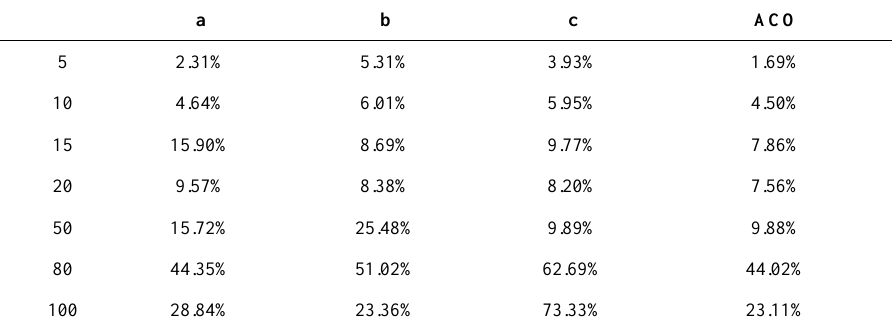
Table 3. A comparison of different solution methods in n=10